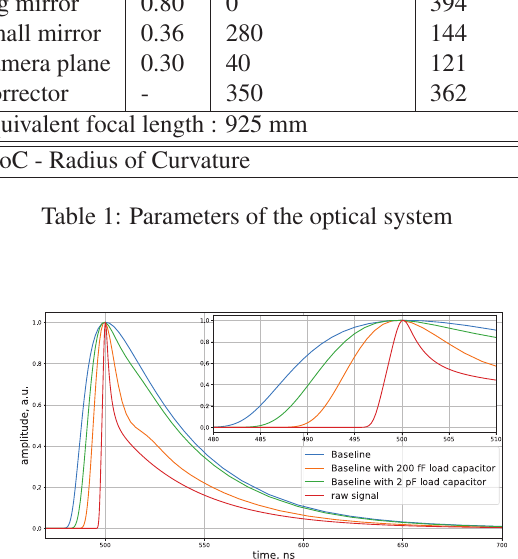
Figure 4: The SiPM signal shape before and after di ff erent amplifier configurations for the NUV-HD-MT from FBK with 25 μ m micro-cell size. The amplitudes are normal- ized to the maximum